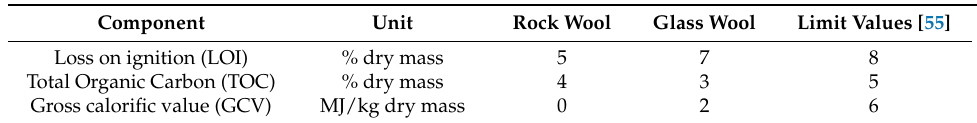
Table 5. Chemical properties of mineral wool that allow for depositing in landfills for non-hazardous and inert waste.